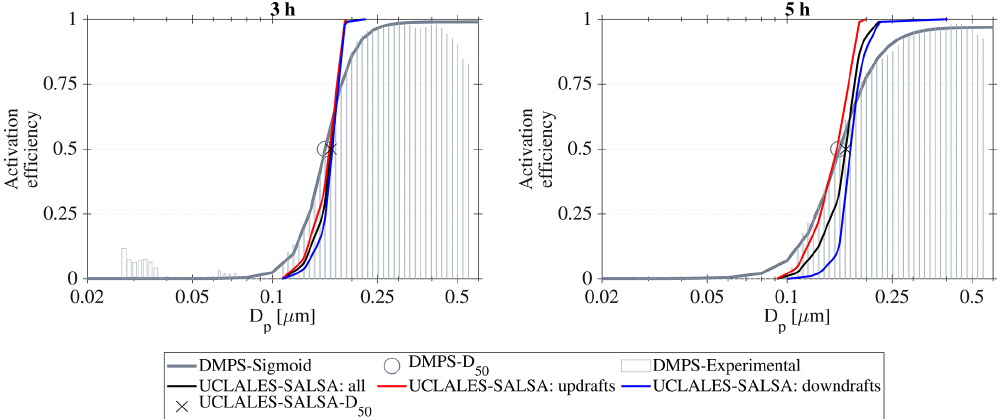
Figure 7. Comparison of activation efficiency curves calculated with UCLALES–SALSA at Puijo altitude of 225m and retrieved from aerosol number concentrations measured by the twin-inlet DMPS system during case 1, 24 September